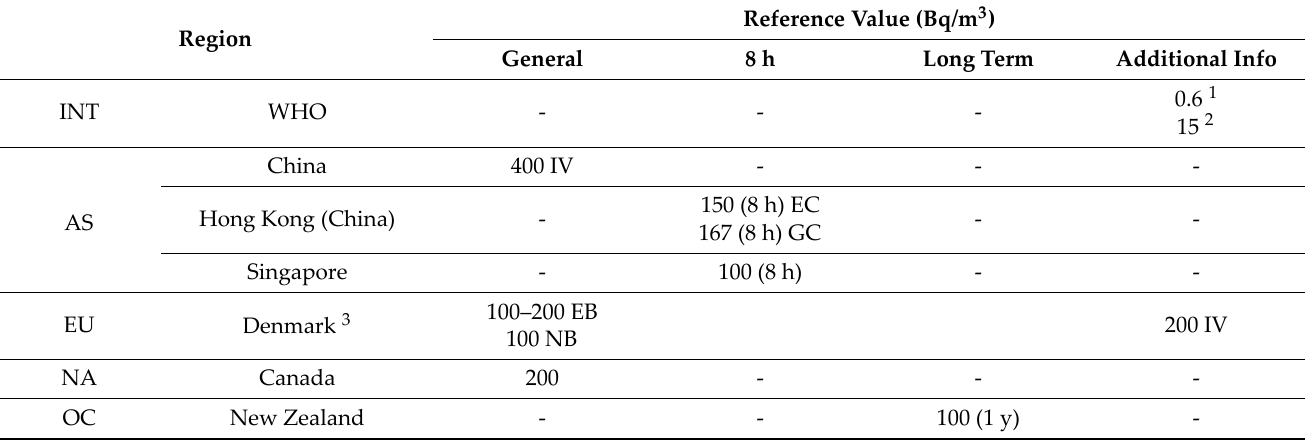
Table 16. Reference value for